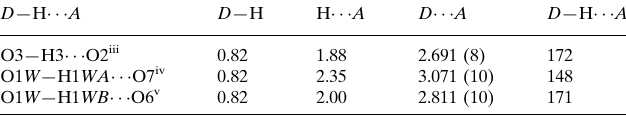
Hydrogen-bond geometry (A˚ , (cid:2)